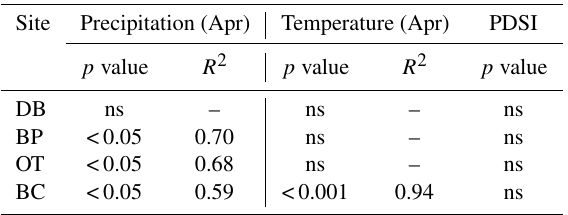
Table 8. Relationships between tree ring (cid:49) 13 C values and early growing season climatic conditions ( α = 0 .